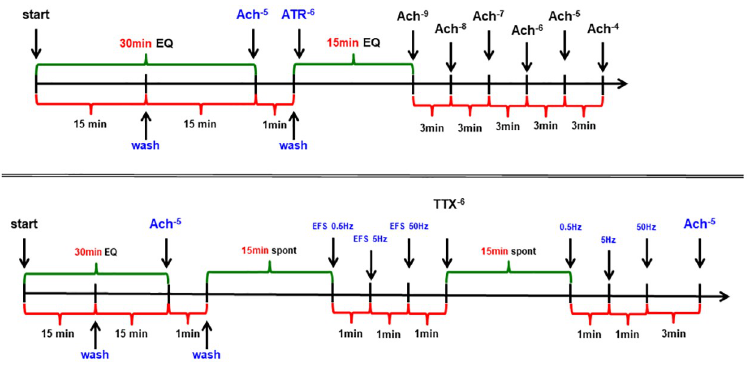
Fig 1. Scheme of the intestinal contractility in vitro